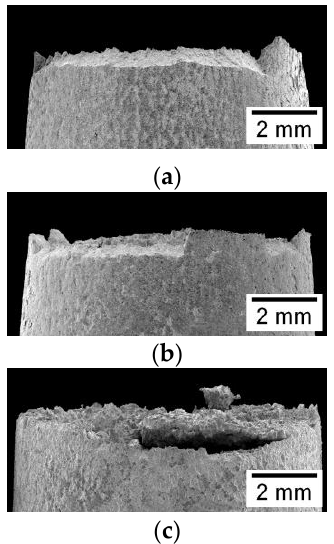
Figure 5. Side view of the fracture surfaces in the steels cooled using: ( a ) AC; ( b ) POF; ( c ) FCF.